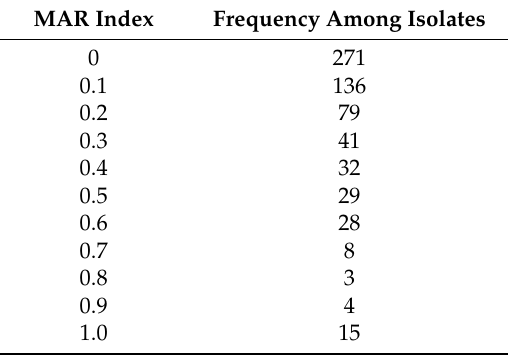
Table 3. Multiple antibiotic resistance of P. aeruginosa in five